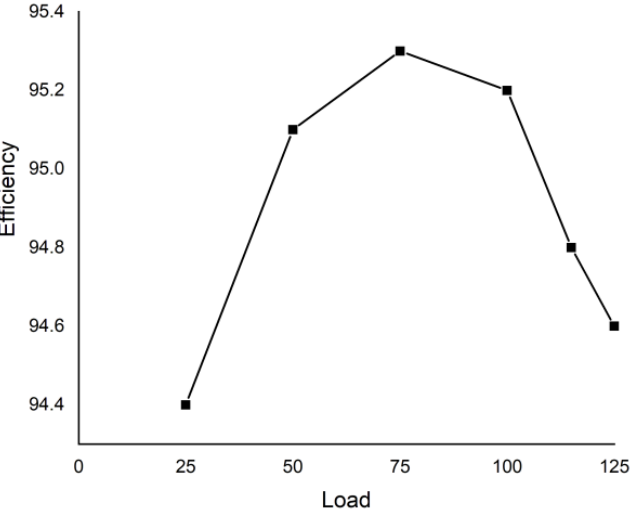
Figure 10. Variation of the efficiency with different loads.